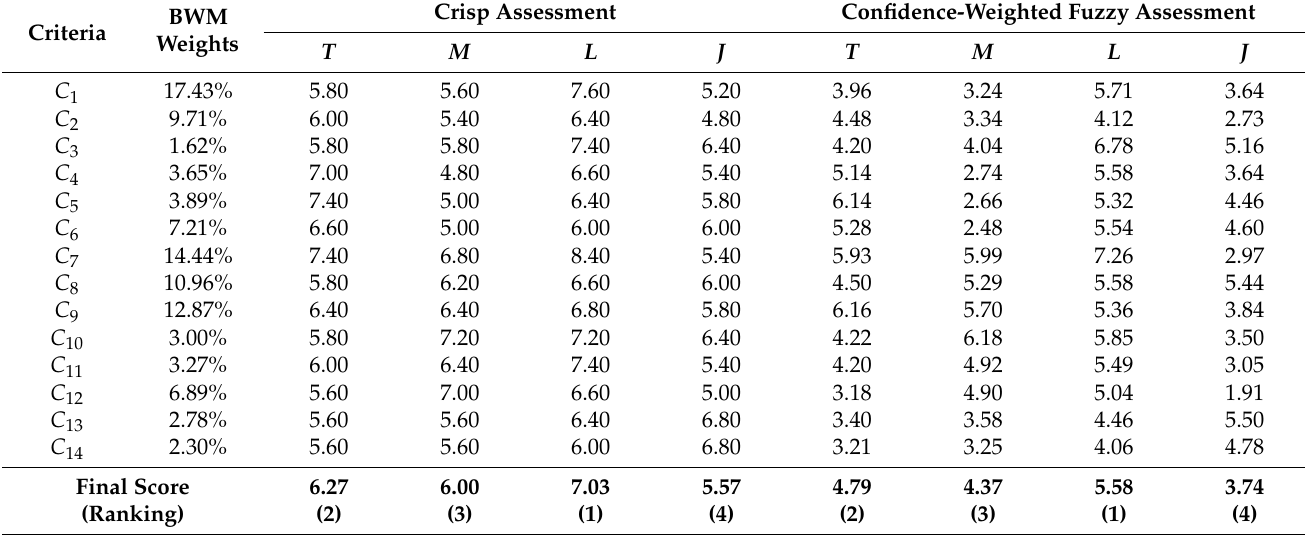
Table 7. BWM+ simple additive weighting (SAW)